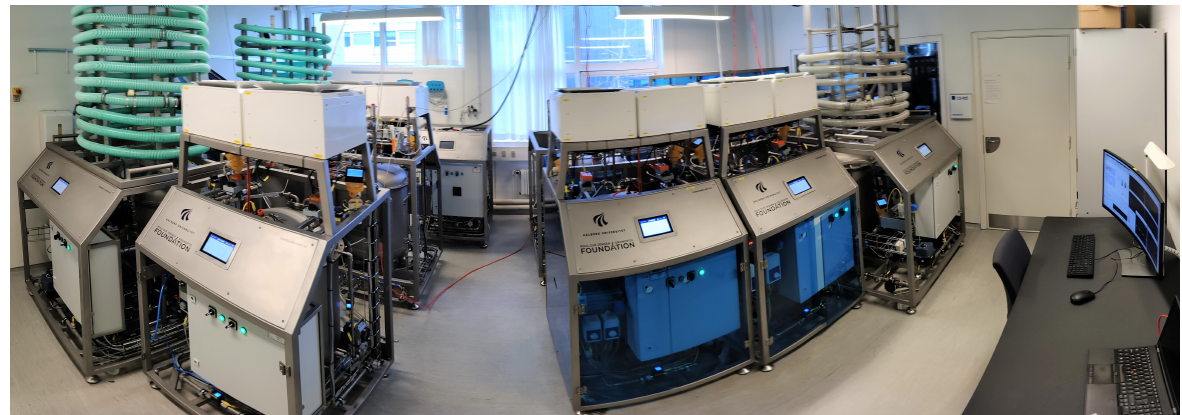
Figure 1. Picture of the SWIL with two test-beds and the SCADA-PC: ( Left ) Waste water collection. ( Center ) Water distribution network. ( Right )